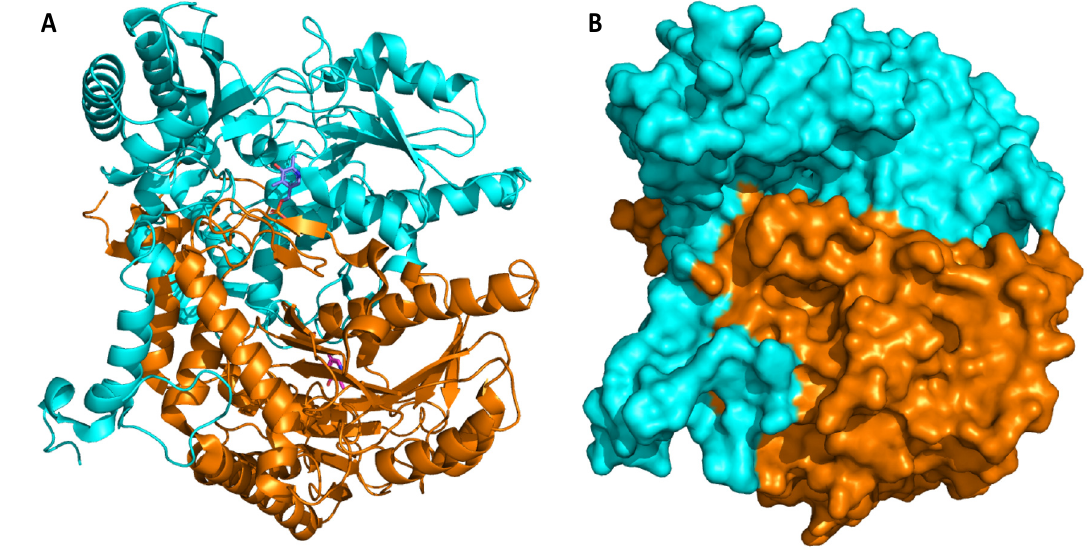
Figure 7. Structure of homodimeric glutamate decarboxylase from L. brevis CGMCC 1306 (PDB code: 5GP4). ( A ): overall secondary structure with chains A and B represented as orange and cyan cartoons, respectively. The prosthetic group PLP is represented as sticks, colored by atom type, with carbons shown in magenta or blue. ( B ). Surface of GAD with chains A and B of the crystal structure represented as orange and cyan surfaces, respectively. Images were made using the PyMOL Molecular Graphics System, v. 2.3.0. for Linux.